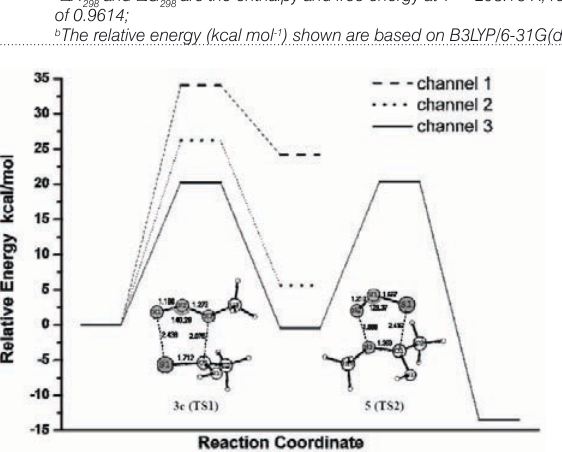
Fig. 1 indicates that the reaction can first start by